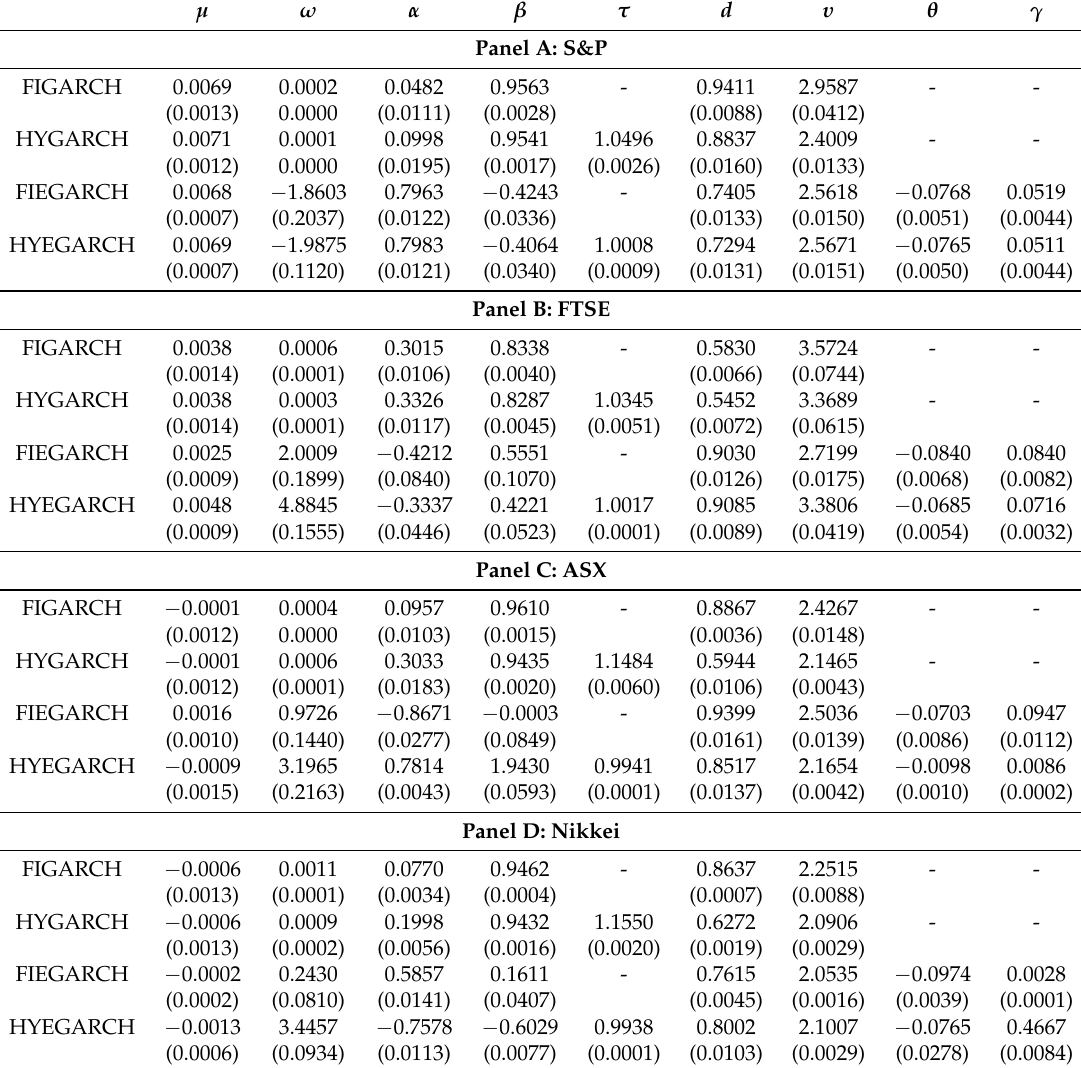
Table 7. Estimation of FIGARCH, HYGARCH, FIEGARCH and HYEGARCH models for stock